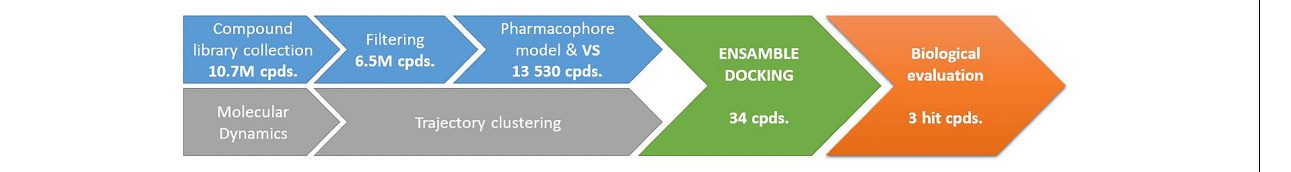
FIGURE 5 | Completed workflow used for identification of UppS inhibitors. Number of processed compounds (cpds.) is indicated under individual steps.